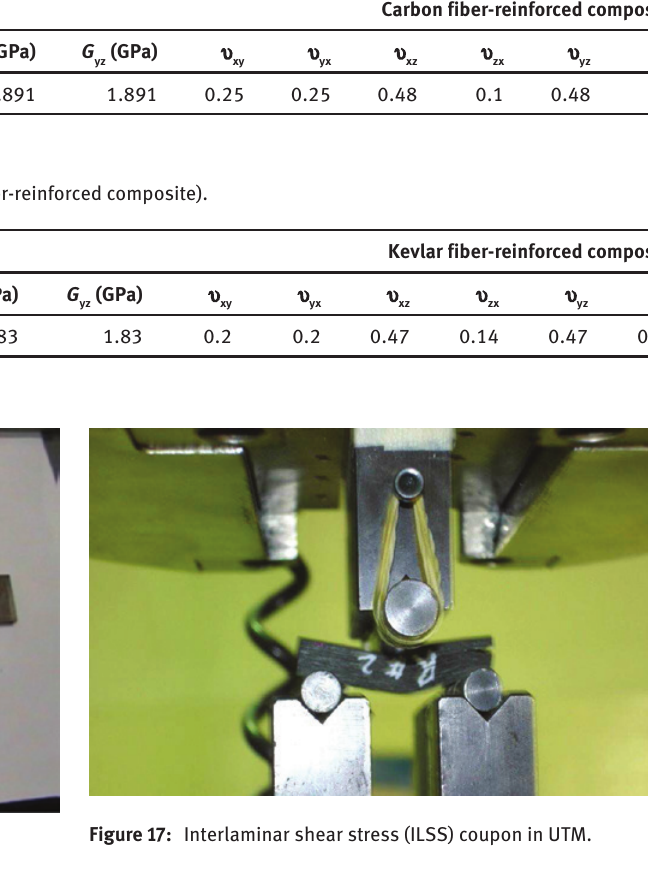
Figure 16: A tensile test specimen.